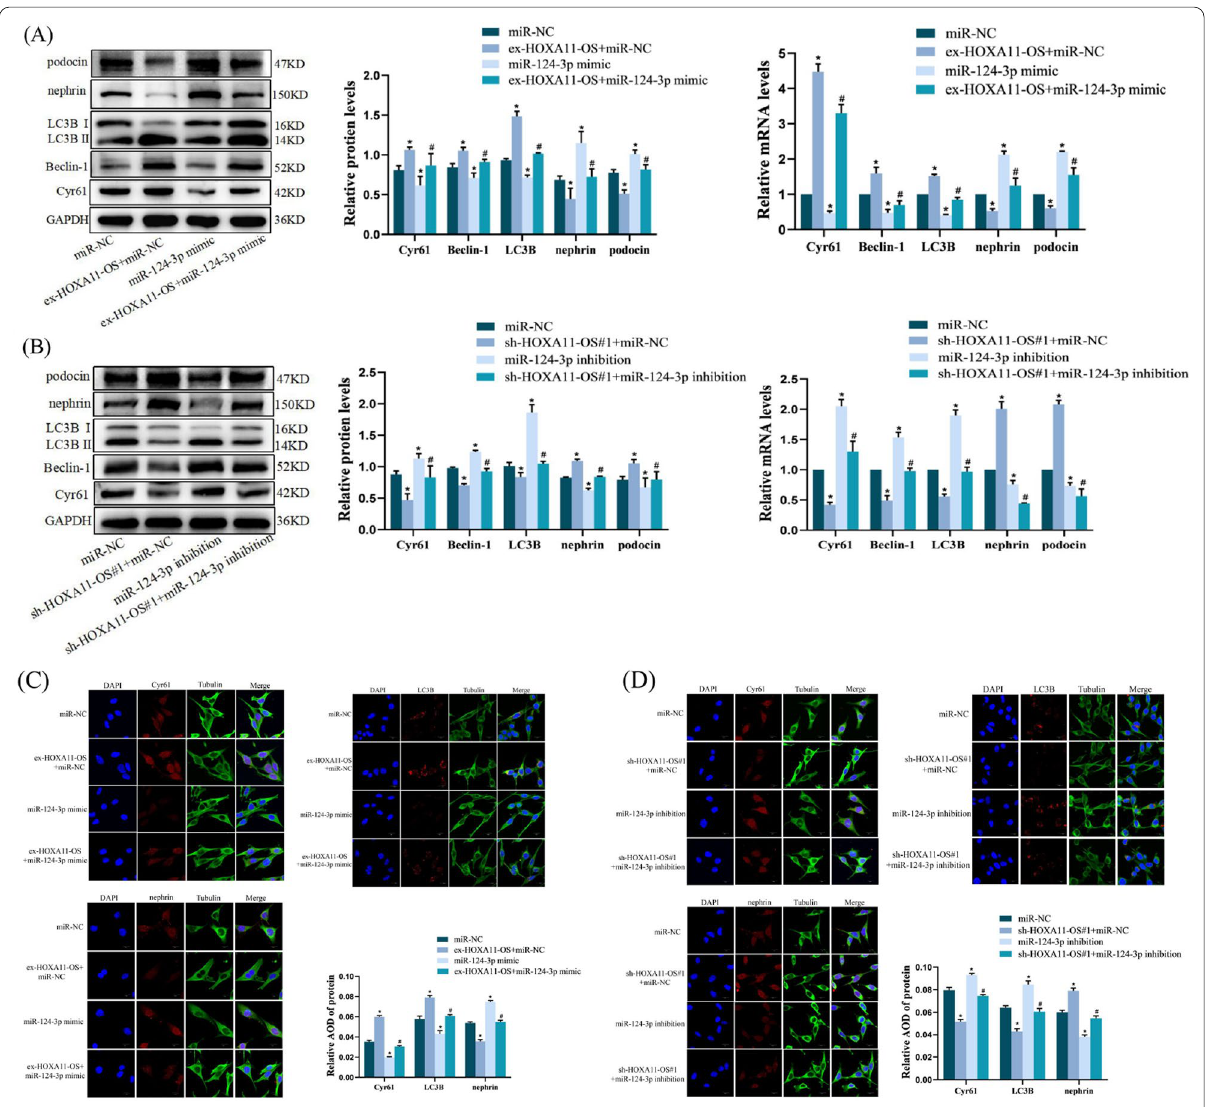
Fig. 4 HOXA11-OS regulates autophagy factors and cell damage by targeting miR-124-3p mediating Cyr61. A The expression of Cyr61, Beclin-1, LC3B, nephrin, and podocin was detected by qRT-PCR and western blotting after transfection of miR-124-3p mimic into the ex-HOXA11-OS cell line. B The expression of Cyr61, Beclin-1, LC3B, nephrin, and podocin was detected by qRT-PCR and western blotting after transfection of miR-124-3p inhibition into the sh-HOXA11-OS#1 cell line. C , D The localization and expression of Cyr61, LC3B, and nephrin were detected by IF. * P < 0.05 vs. miR-NC; # P < 0.05 vs. ex-HOXA11-OS miR-NC/sh-HOXA11-OS#1 miR-NC. Data are presented as means standard deviation. Scale bars represent + + ± 15